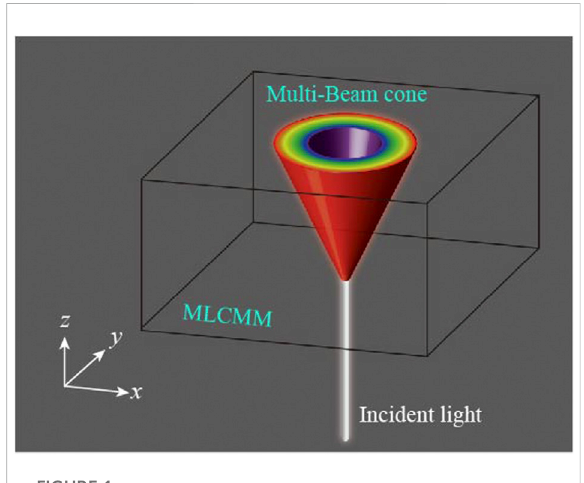
FIGURE 1 Schematicofthemulti-beamconeintheMLCMM.The beam splitting will occur when the light incident on the